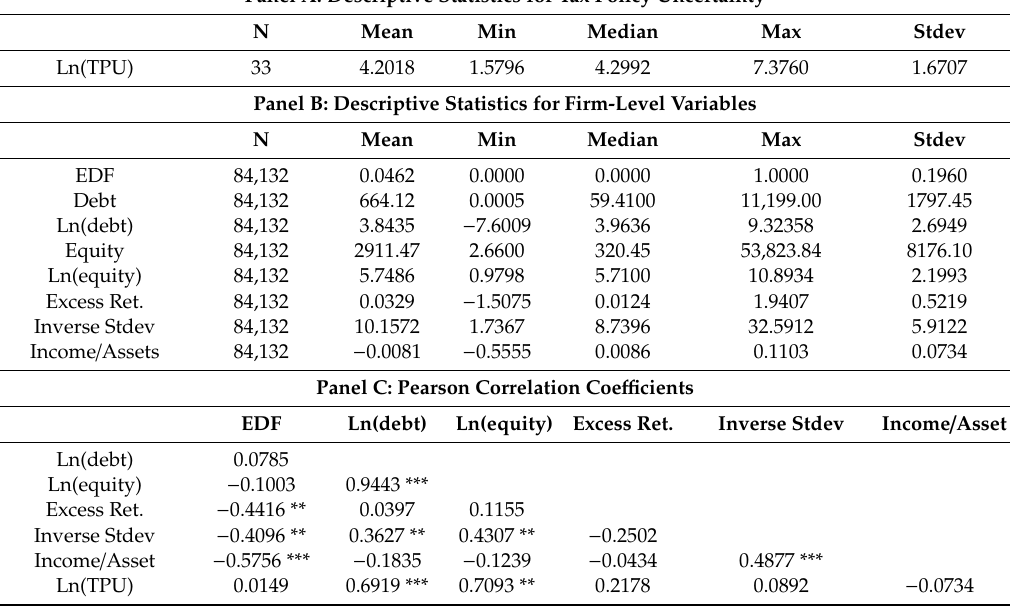
Tax policy uncertainty variable is available in time-series. We calculate the means of all firm-level variables each year and turn them into time-series and calculate correlation coe ffi cients. Symbols **, and *** indicate statistical significance at 10%, 5%, and 1% levels,